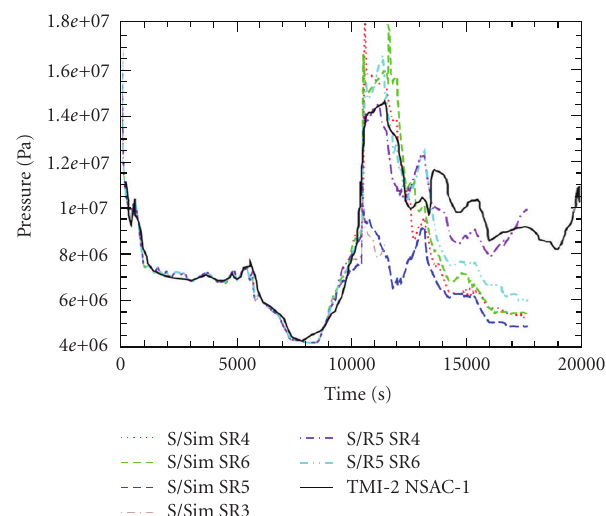
Figure 8: Example of RELAP/SDAPSIM and SCDAP/RELAP5 TMI-2-calculated results for system pressure for a range of metallic fuel rod material relocation modeling